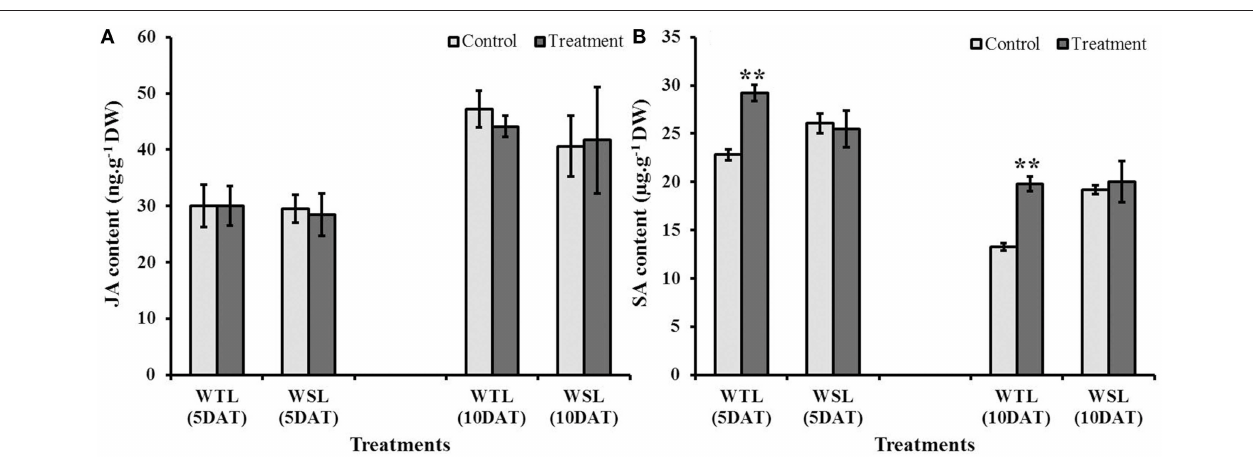
at WTL ( Figures 7A,B ), while development of aerenchyma cell was not different between the control and treatment in WSL ( Figures 7C,D ). Therefore, aerenchyma cells were